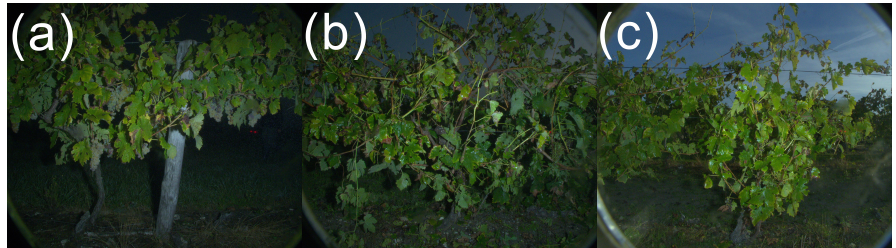
Figure 10. Example of the illumination evolution effect on the pictures taken over the course of the morning (from ( a – c )) using a flash device with the same settings. Images extracted from the flavescence dorée detection ProspectFD